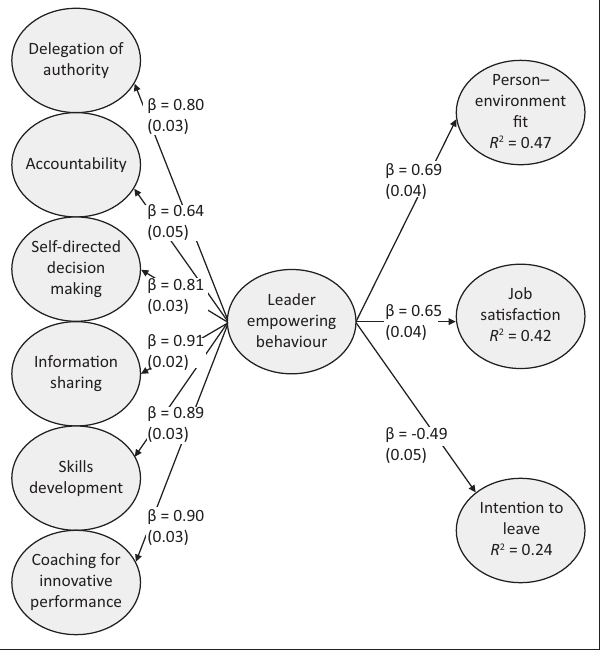
FIGURE 1: The hypothesised structural model (standard errors in